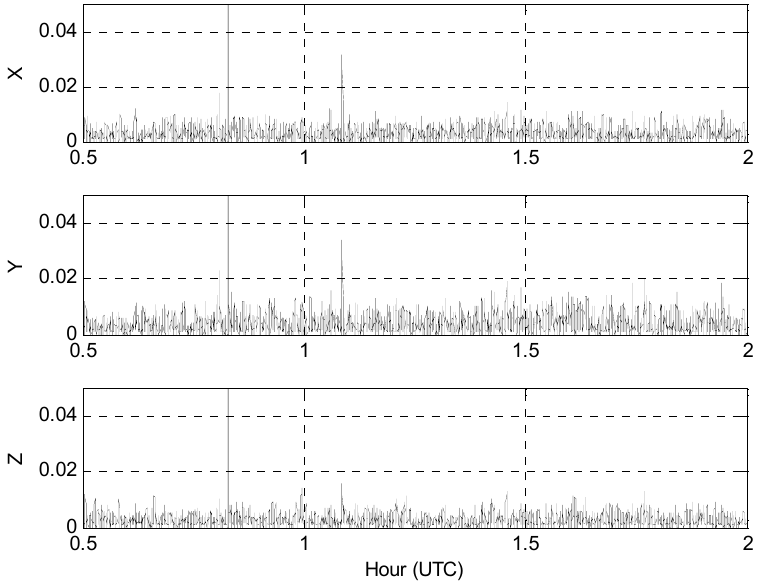
Figure 3. Receiver A minus receiver B acceleration root-mean-squared differences in m/s 2 from Figure 2. Table 1. Statistical mean and standard deviation (Std) values of the RMS differences in m/s 2 between the kinematic accelerations for receivers A and B in Figure 2. The correlation coefficients (CC (A,B)) between the datasets of the two receivers are also listed with the related % noise contributions from Equation (2).